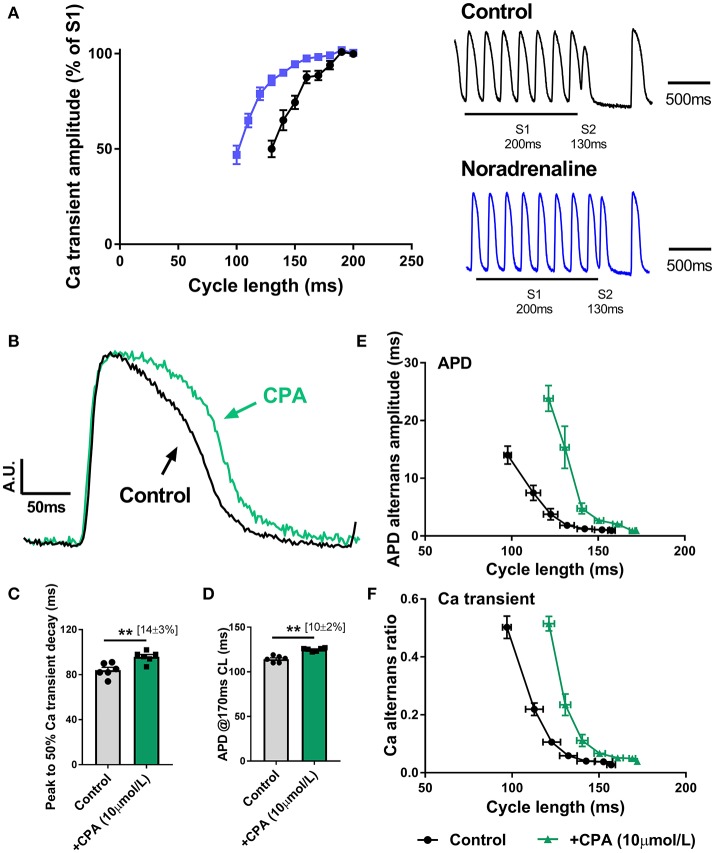
Role of altered Ca handling in the action of sympathetic nerve stimulation on cardiac alternans (A) S1S2 (extra-stimulus) Ca transient amplitude restitution relationships in the presence and absence of noradrenaline (200 nmol/L). Inset are representative traces of a single extra-stimulus (S2) at a 130 ms cycle length in the absence and presence of noradrenaline. (B) Amplitude-normalized intracellular Ca transients recorded in control conditions and with cyclopiazonic acid (CPA, 10 μmol/L). (C,D) Data on the effects of CPA on action potential duration (APD) and the time to 50% decay of the intracellular Ca transient. (E,F) Data on the cycle length relationships for APD and Ca amplitude alternans. Data taken from a 3 × 3 pixel region in the basal left ventricle. Paired Student's t-test; **p < 0.01. Data are mean ± SEM. (n = 5–6 hearts).